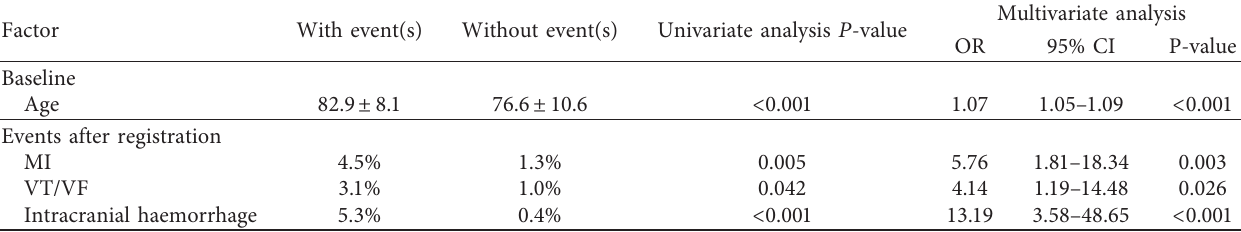
Table 3: Risk factors for all-cause mortality in patients with ischaemic heart disease.